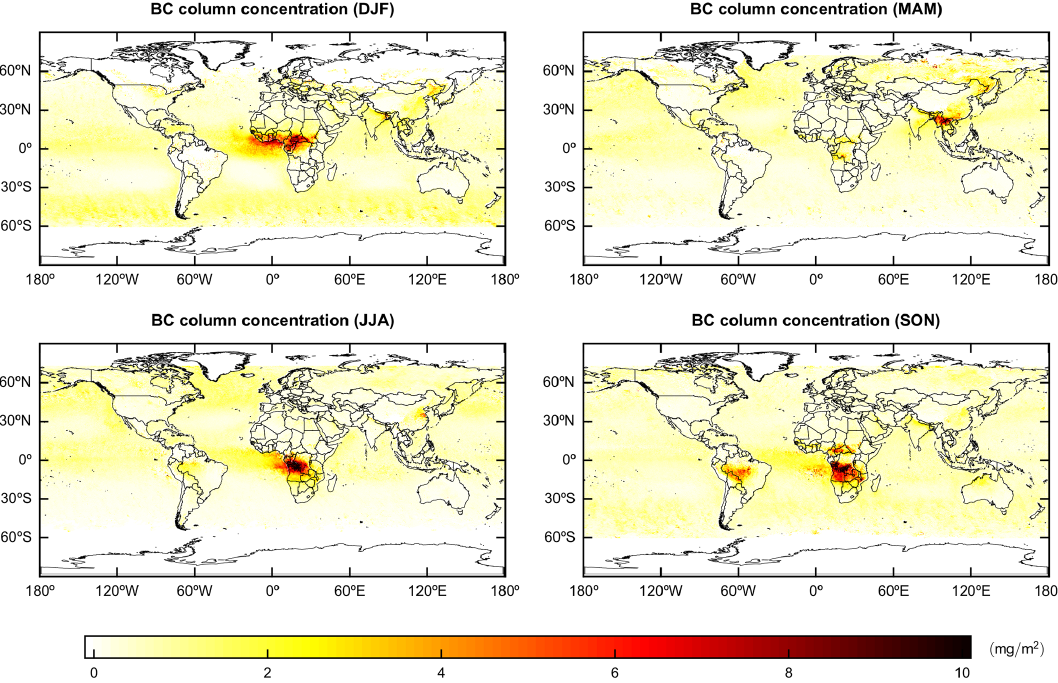
Figure 1. Spatial distribution of seasonal BC column mass concentration (mgm − 2 ) derived from POLDER-3 observations using the